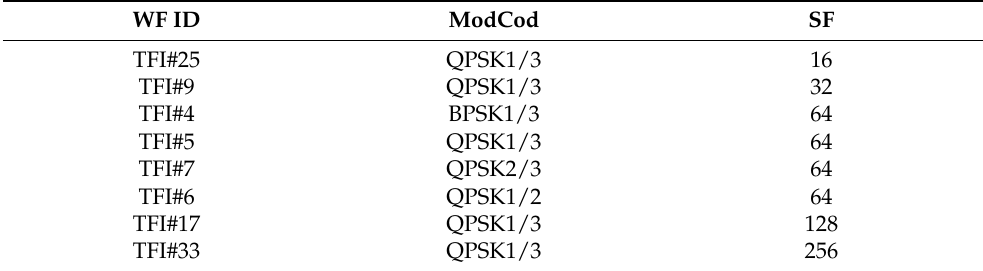
Table 1. Return Link